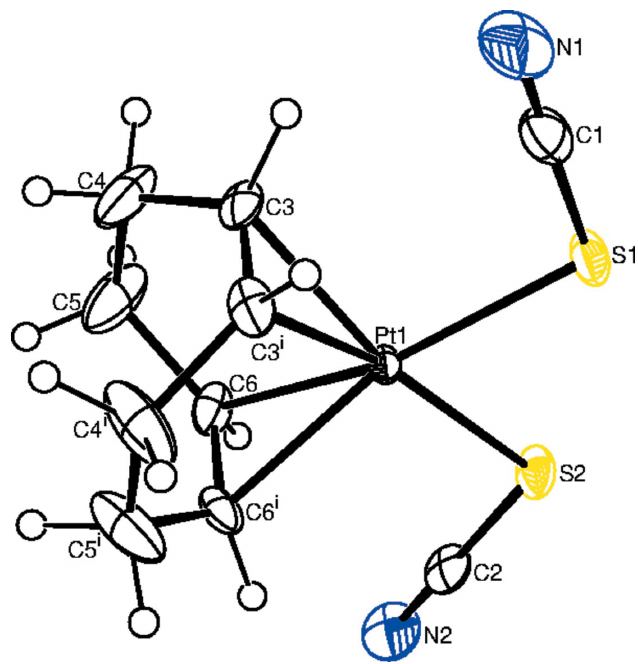
Figure 1 The molecular structure of the title complex showing the atom labelling and displacement ellipsoids drawn at the 40% probability level for non-H (cid:2) y , z atoms [symmetry code: (i) x , 1 2